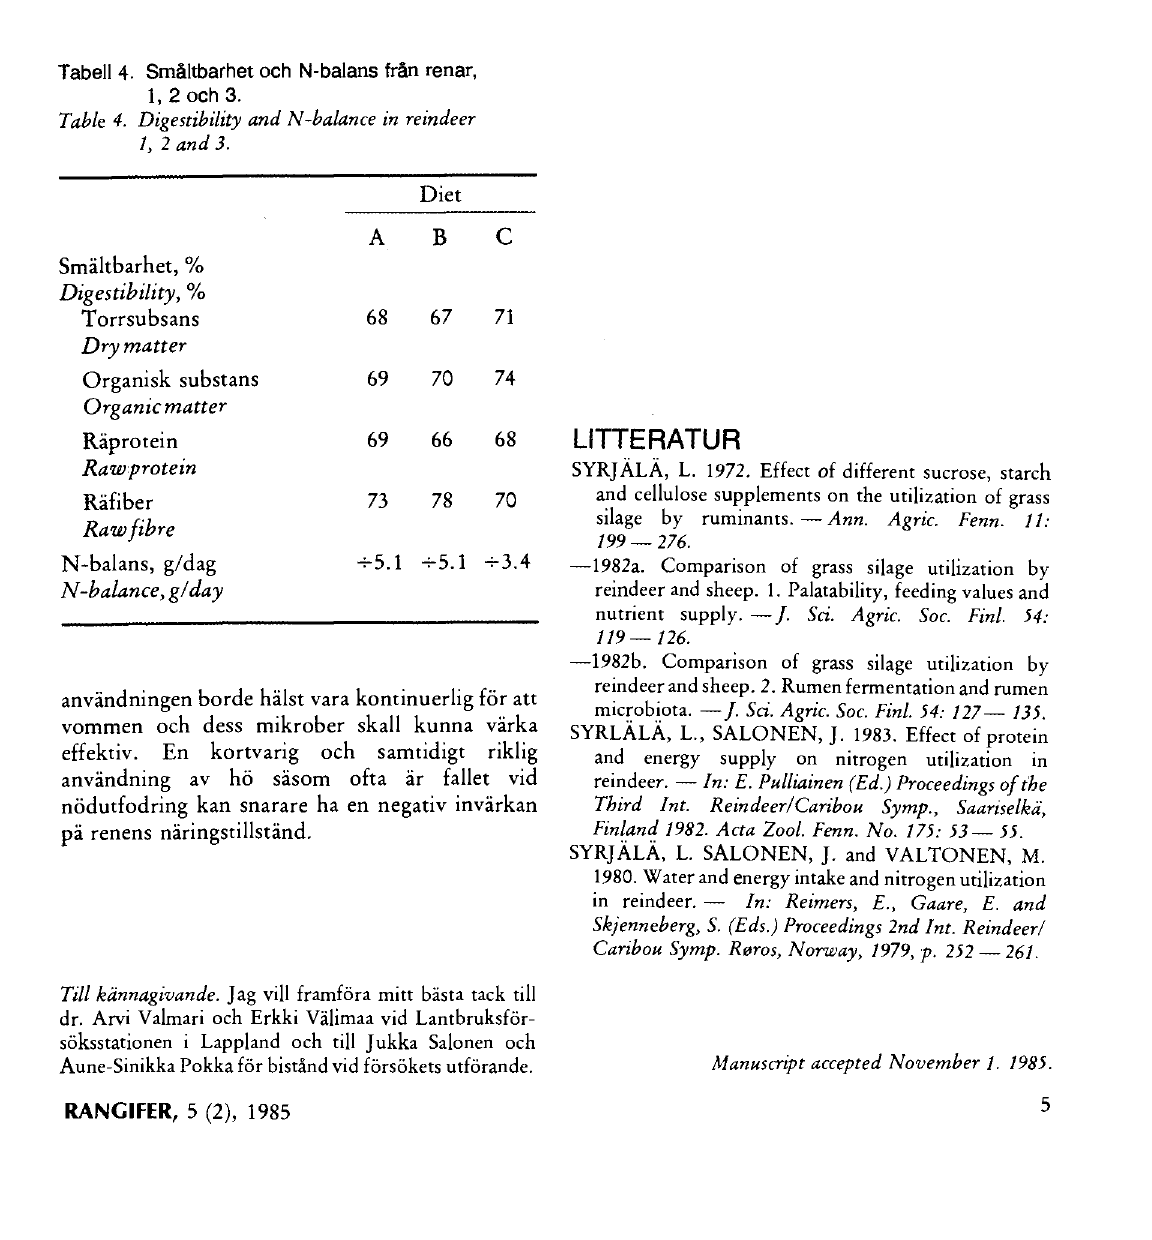
Table 4. Digestibility and N-balance in reindeer 1, 2 and